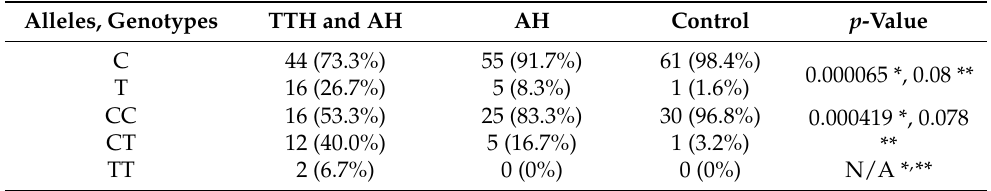
Table 2. Allele frequencies and genotype distribution of rs3782218 of the NOS1 gene. Alleles, Genotypes TTH and AH AH Control p -Value C 44 (73.3%) 55 (91.7%) 61 (98.4%)